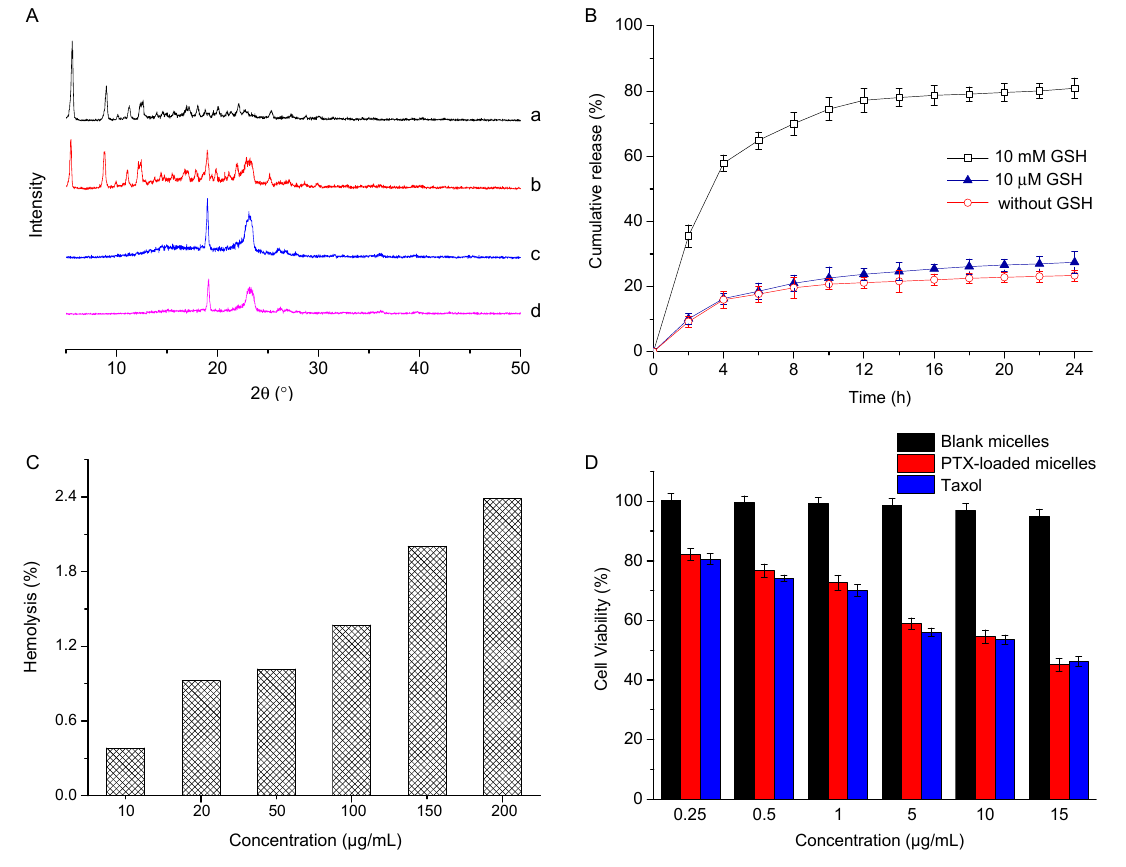
Figure 3. Characterization of PTX-loaded Bi(mPEG-S-S)-TPE micelles. ( A ) XRD diagrams of (a) PTX, (b) physical mixture of PTX and bare micelles, (c) PTX-loaded Bi(mPEG-S-S)-TPE micelles, and (d) bare Bi(mPEG-S-S)-TPE micelles. ( B ) In vitro drug release patterns of PTX-loaded Bi(mPEG-S-S)-TPE micelles under different GSH concentrations. ( C ) Hemolysis of PTX-loaded Bi(mPEG-S-S)-TPE micelles at different concentrations. ( D ) In vitro cytotoxicity of PTX-loaded Bi(mPEG-S-S)-TPE micelles against MCF-7 cells.